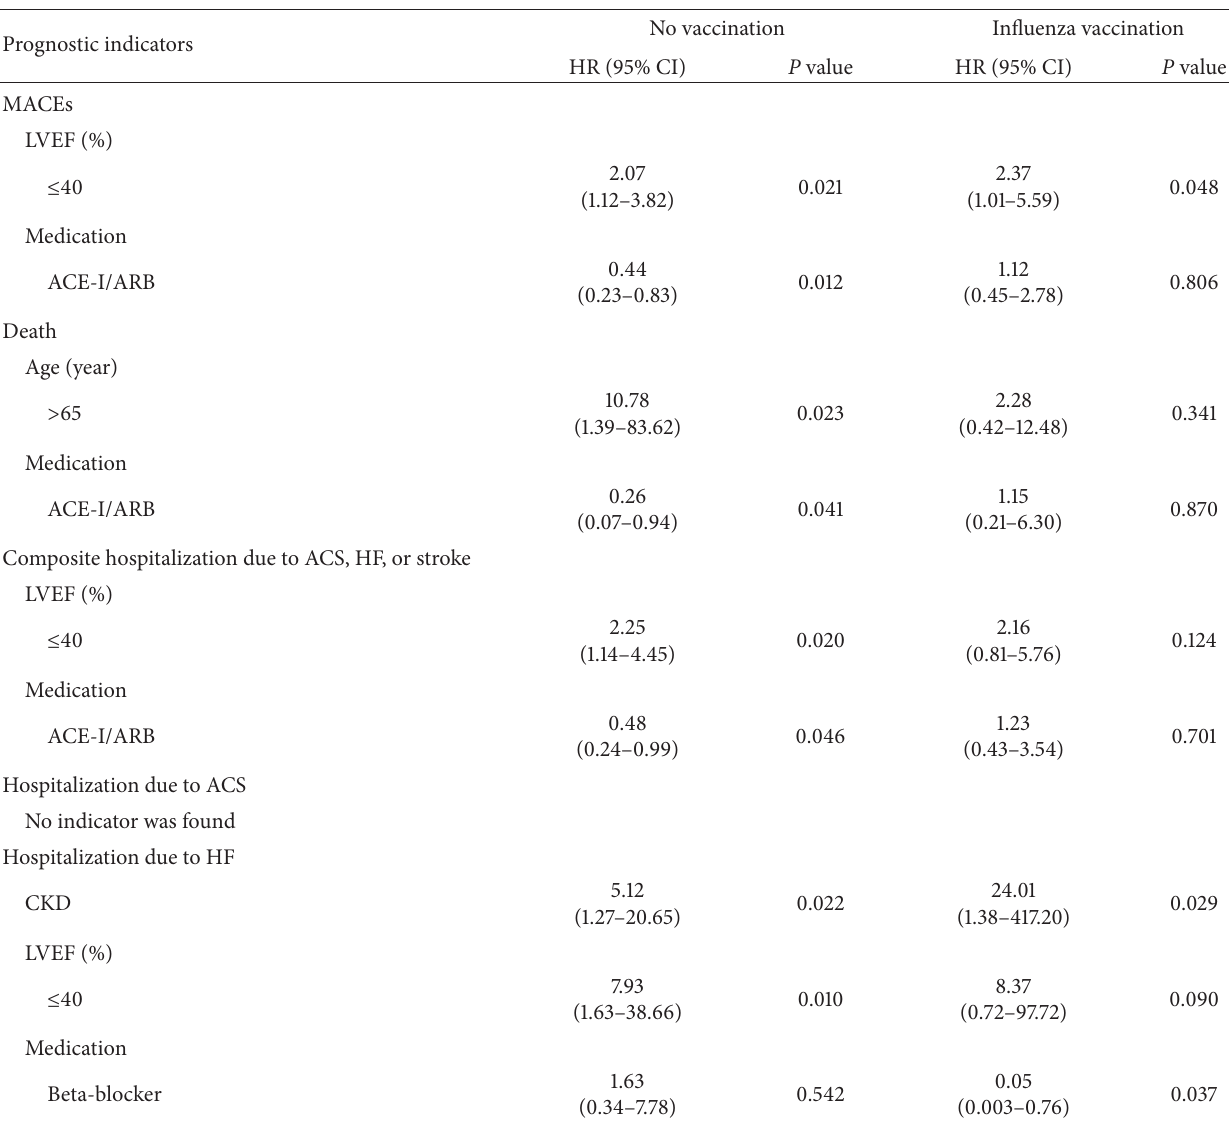
Table 3: Multivariable hazard ratios stratified by influenza vaccination for each cardiovascular event, which was analyzed by multivariable stratified Cox’s regression